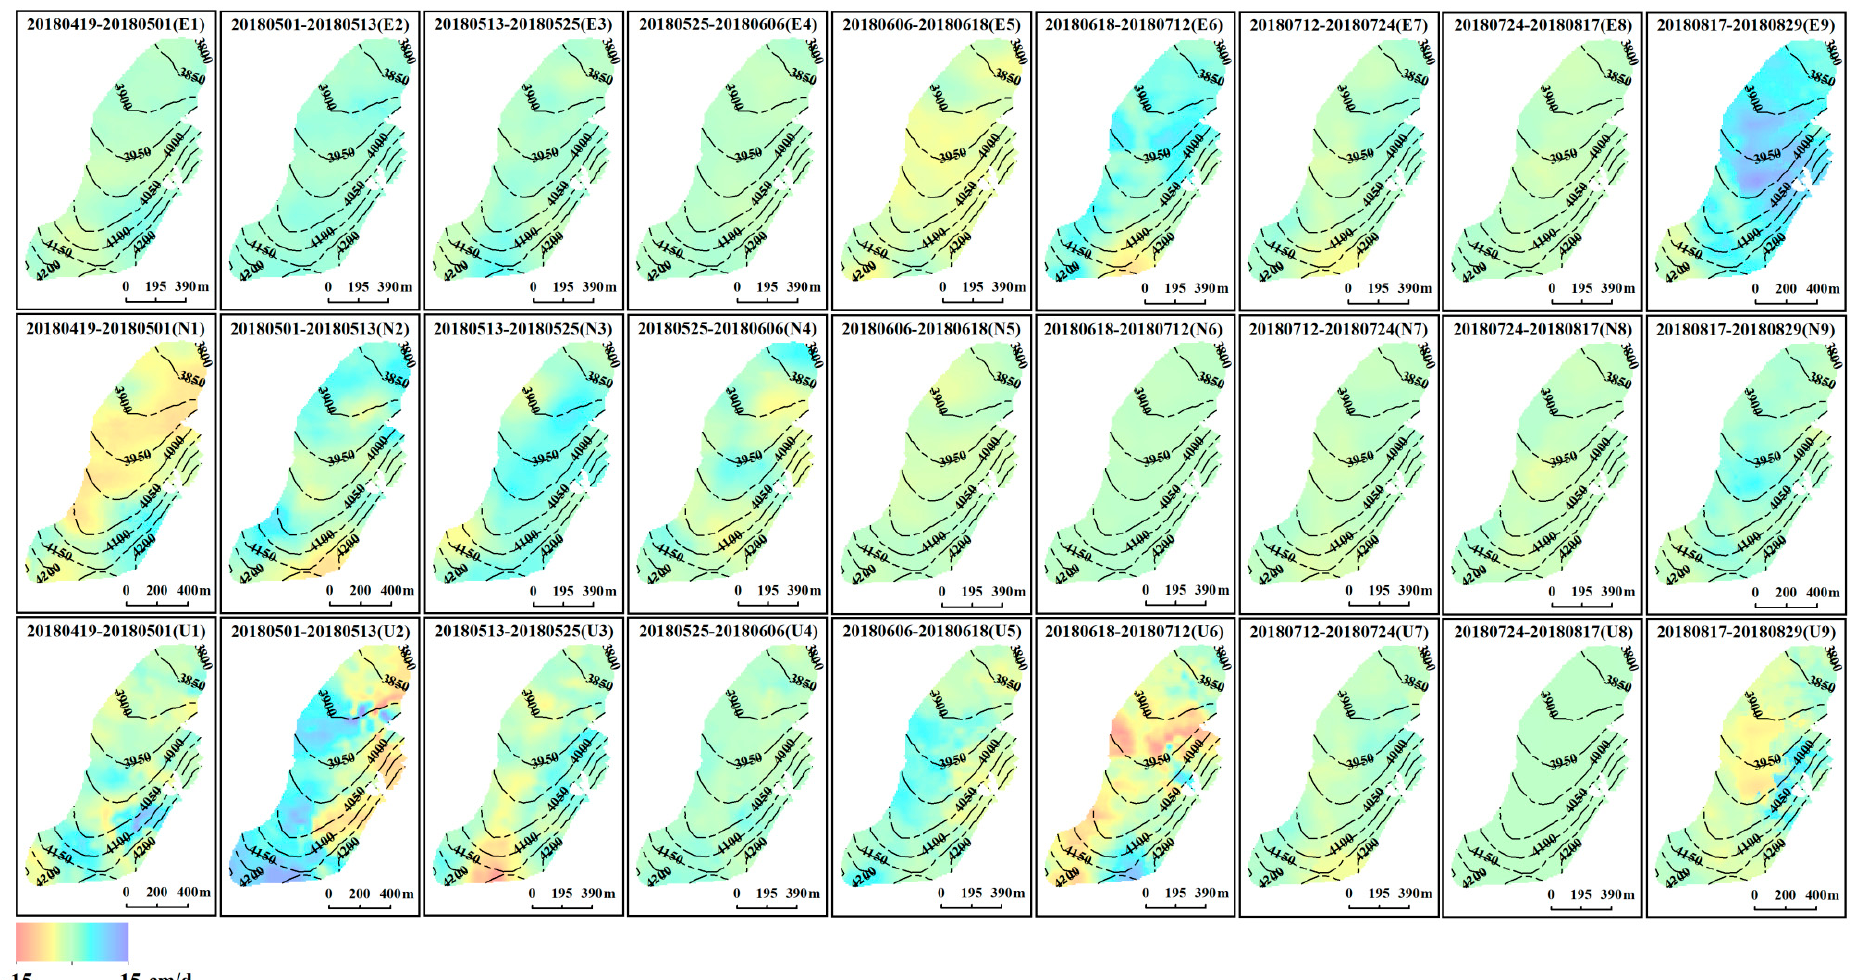
Figure 8. The motion velocity distribution of the east branch of Urumqi Glacier No. 1 in each period of time in the direction of east, north and vertical (unit: cm/d).